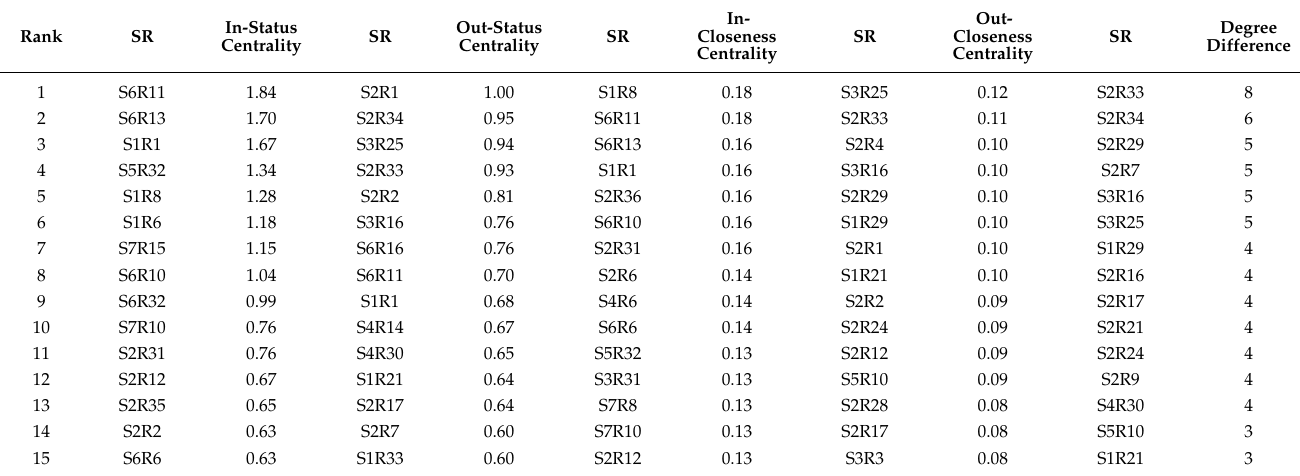
Table 2. Critical risk factors based on node